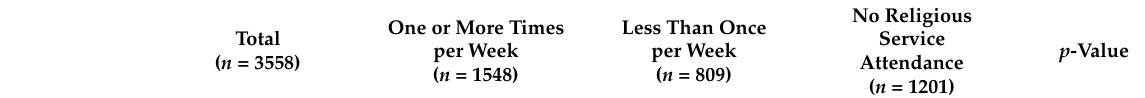
Table 2. Distribution of Allostatic Load Components of NHANES III Participants with Chronic Kidney Disease for the Total Sample and by Religious Service